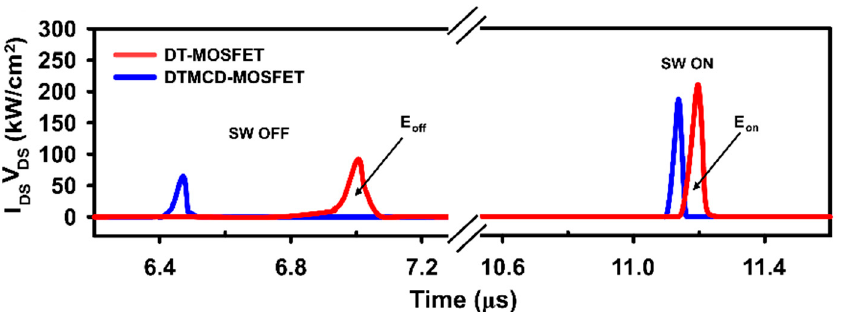
Figure 12. Switching waveforms of DT-MOSFET and DTMCD-MOSFET.